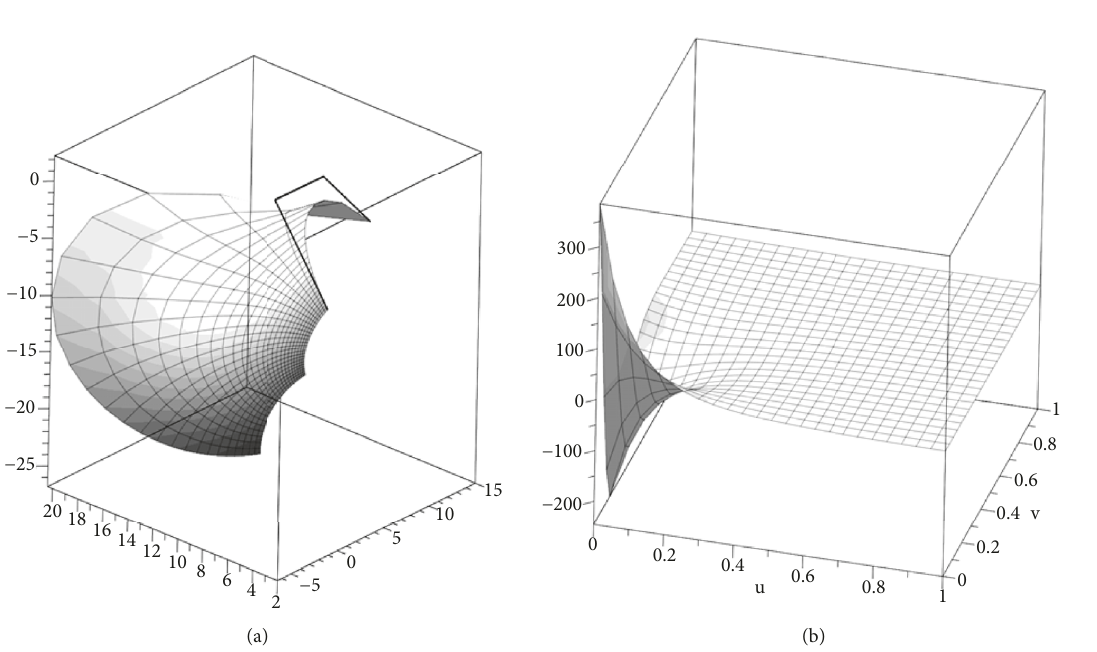
Figure 6: Minimal surfaces built on the basis of a fractional-rational curve. (a) The surface. The reference points are connected by broken bold line. (b) Graph of the function M .